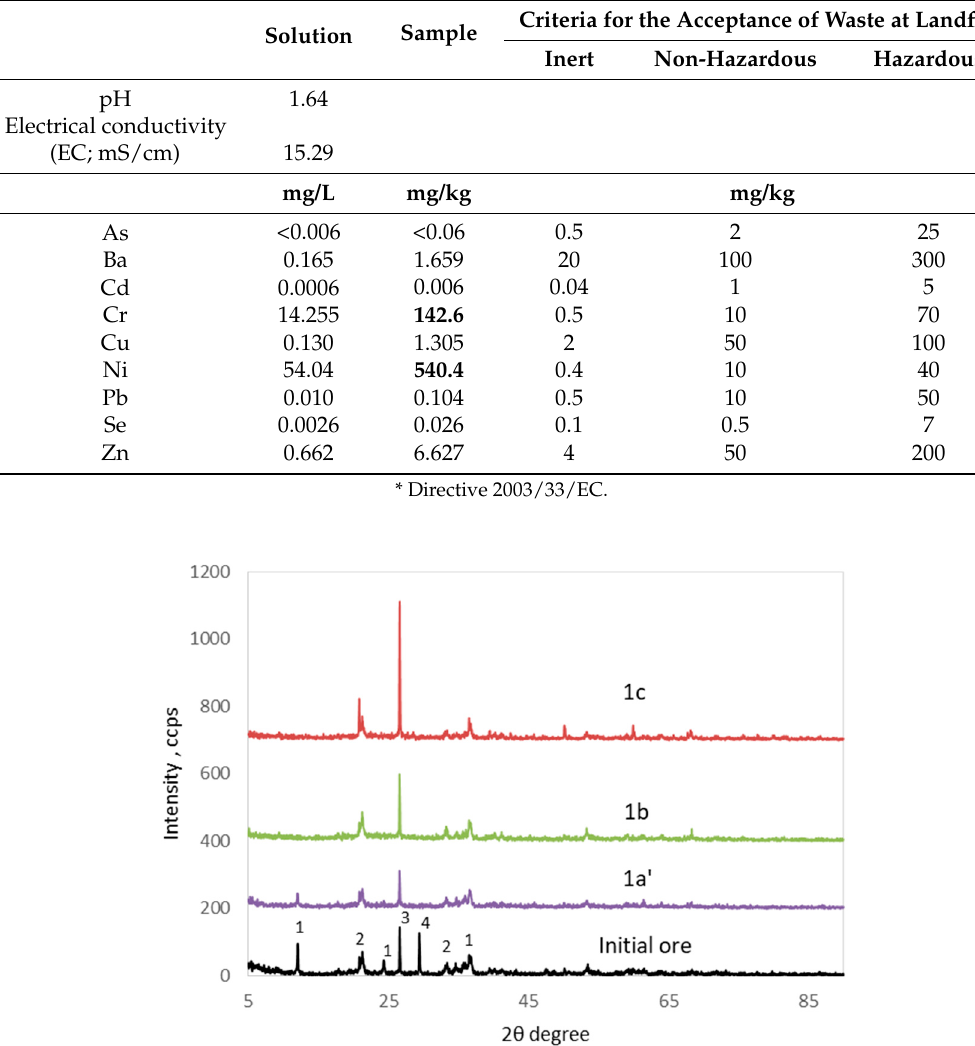
Table 6. Results of the ΕΝ 12457.02 (L/S = 10 L/kg) leaching test for the washed CCL solid residue and comparison with the existing criteria for the acceptance of waste at inert non-hazardous and hazardous landfills (Directive 2003/33/EC).